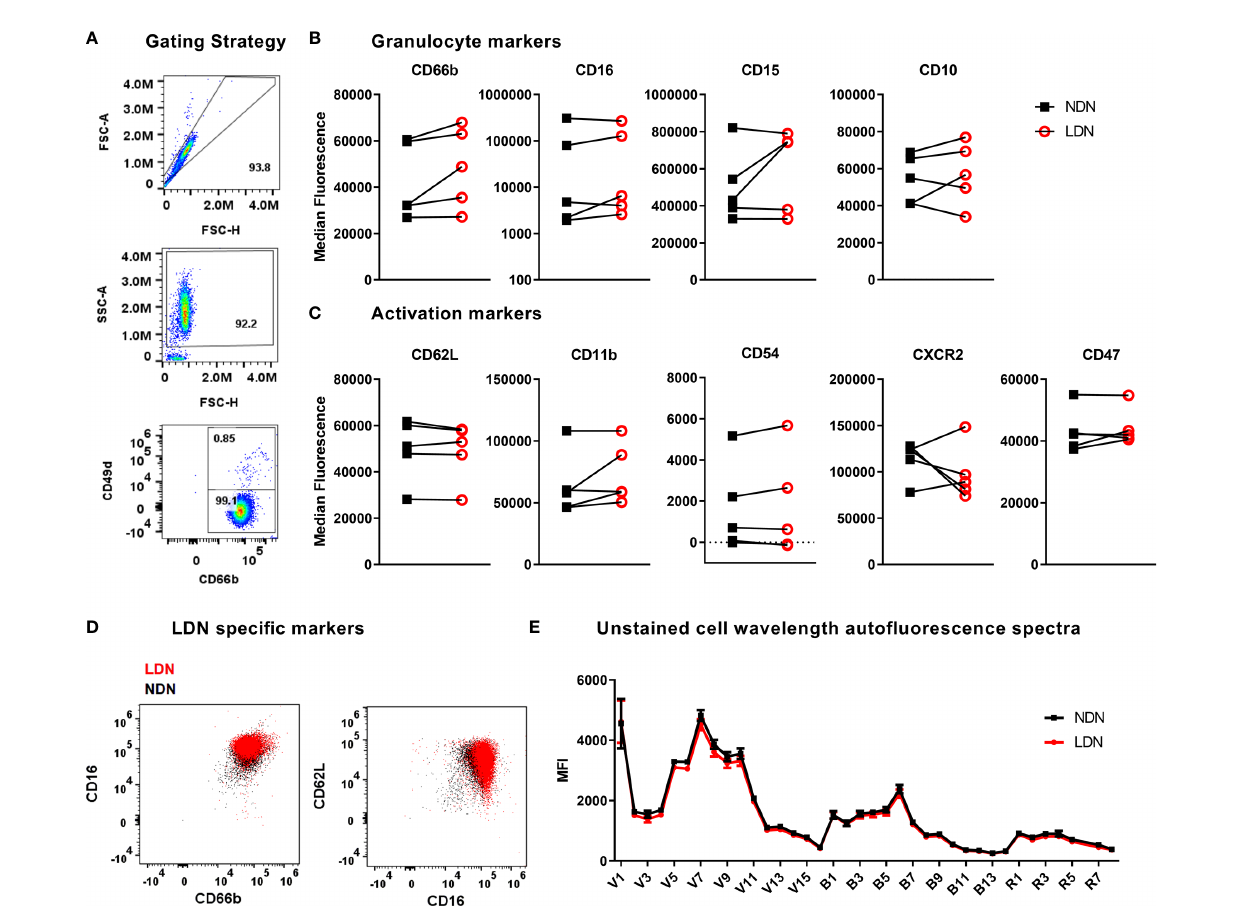
FIGURE 2 | Expression of neutrophil markers on LDN and NDNs (A) Gating strategy to identify neutrophils (CD66b + CD49d - ) and remove any remaining eosinophils (CD66b + CD49d + ) after magnetic isolation. (B) Markers of neutrophil maturation measured by fl ow cytometry, shown as median fl uorescence intensity (N=5). Linked samples show LDN and NDN from the same donor. (C) Markers of neutrophil activation measured by fl ow cytometry, shown as median fl uorescence intensity (N=5). (D) NDN overlaid with LDN from a representative healthy donor to demonstrate combinations of markers previously reported to identify low density neutrophils, CD16 HI , CD66b HI and CD62L LO ,CD66b + . (E) Spectral intensity recorded on unstained LDN and NDN cells (N=5, Mean ± SEM error